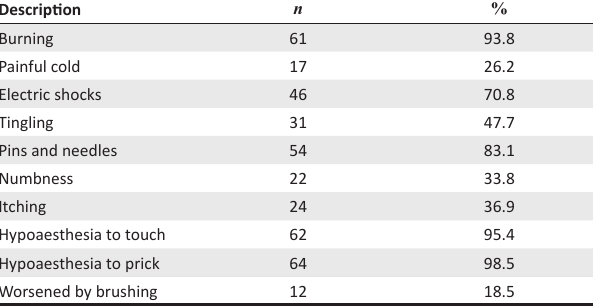
TABLE 4: Douleur neuropathique 4 descriptive statistics ( n = 65).